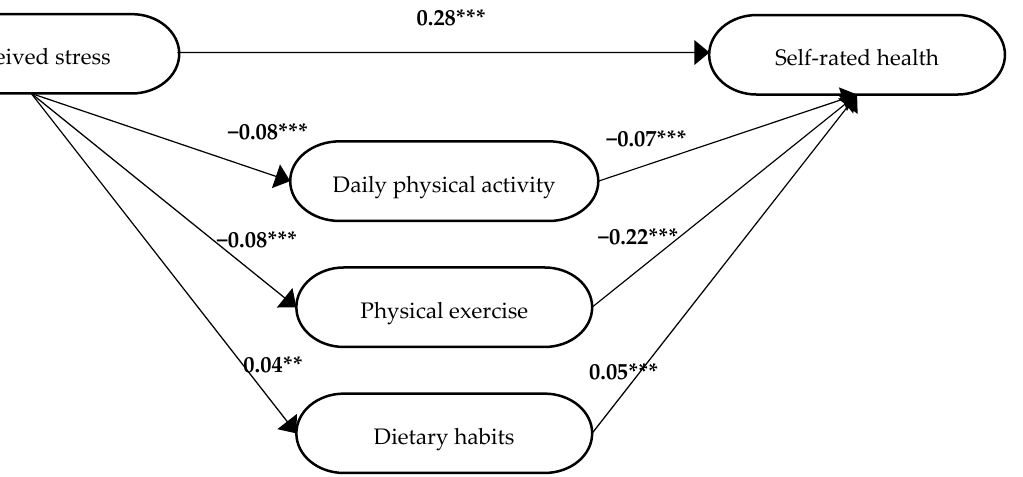
Figure 4. The final model for participants who did not report any of the requested diagnoses. The standardized beta coefficients ( β ) are included for the paths between the independent variable, i.e., perceived stress, the mediators, i.e., daily physical activity, physical exercise, and dietary habits, and the dependent variable, i.e., self-rated health. ** p ≤ 0.01, *** p ≤ 0.001.